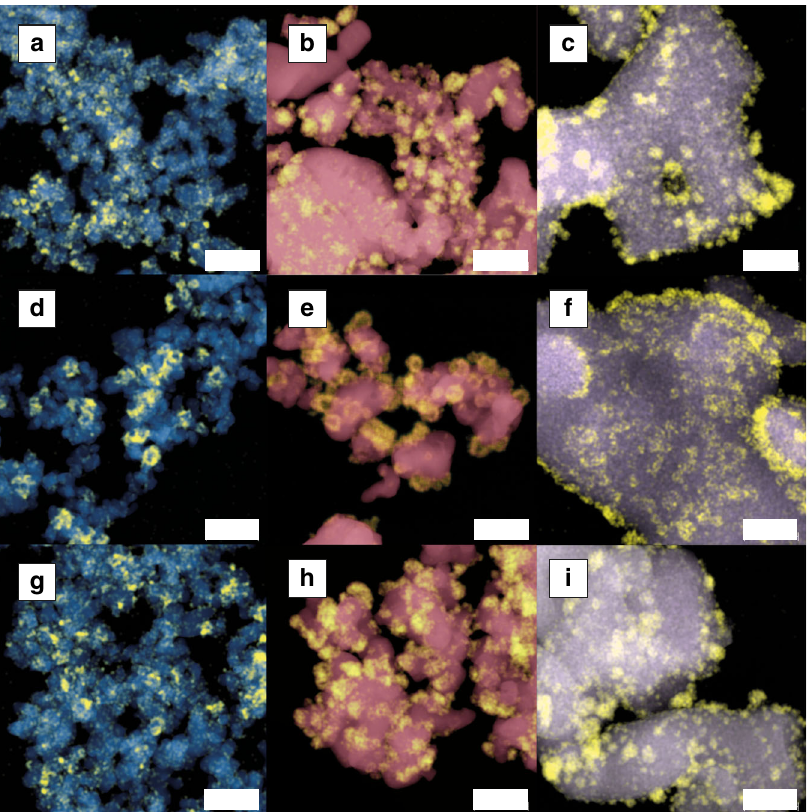
Fig. 1 Electron microscopy images of the samples upon reduction-oxidation-reduction treatments. STEM-EDX mapping of Co/TiO 2 , Co/Nb 2 O 5 , and Co/ α - Al 2 O 3 at various stages of the ROR treatment. Co is depicted in yellow, Ti in blue, Nb in red, and Al in violet. a – c Samples after reduction at 350 °C and passivation (R-samples). d – f Samples after reduction at 350 °C and oxidation at 200 °C (RO200-samples). g – i Samples after reduction at 350 °C, oxidation at 200 °C, and reduction at 220°C (RO200R-samples) and passivation. The scale bars corresponds to 100 nm. Additional electron microscopy results for these samples can be found in Supplementary Figures 1 – 3